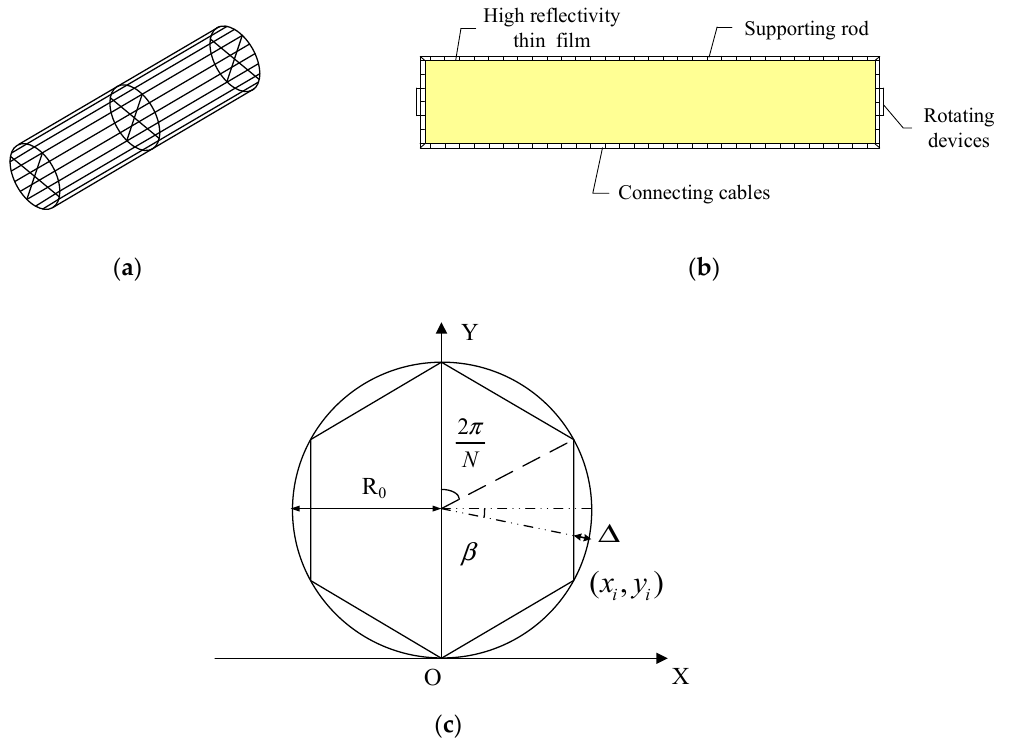
Figure 9. Configuration of the modular concentrator: ( a ) supporting structure; ( b ) thin-film reflector module; ( c ) illustration of split joint.